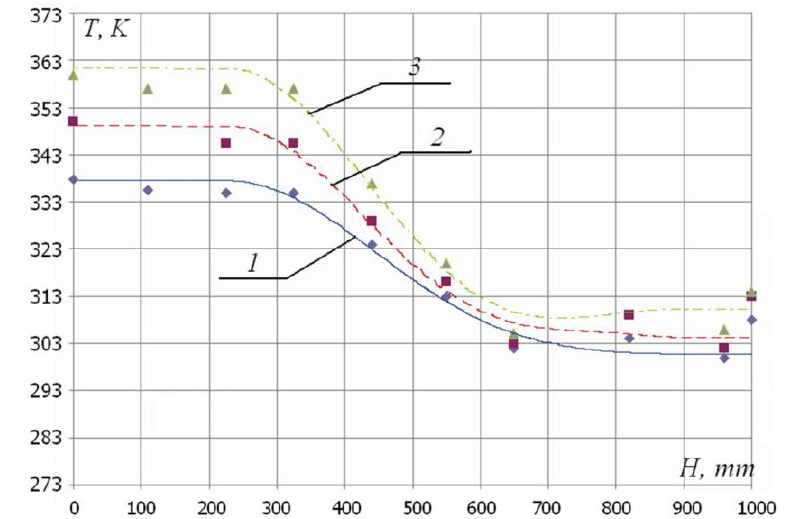
Figure 2 . The temperature distribution in the direction y . The comparison between numerical results and the experimental. [5]. 1( ) – Q h =11,4·10 5 W/m 2 , 2( ) – Q h =16,3·10 5 W/m 2 , 3( ) – Q h =22,8·10 5 W/m 2